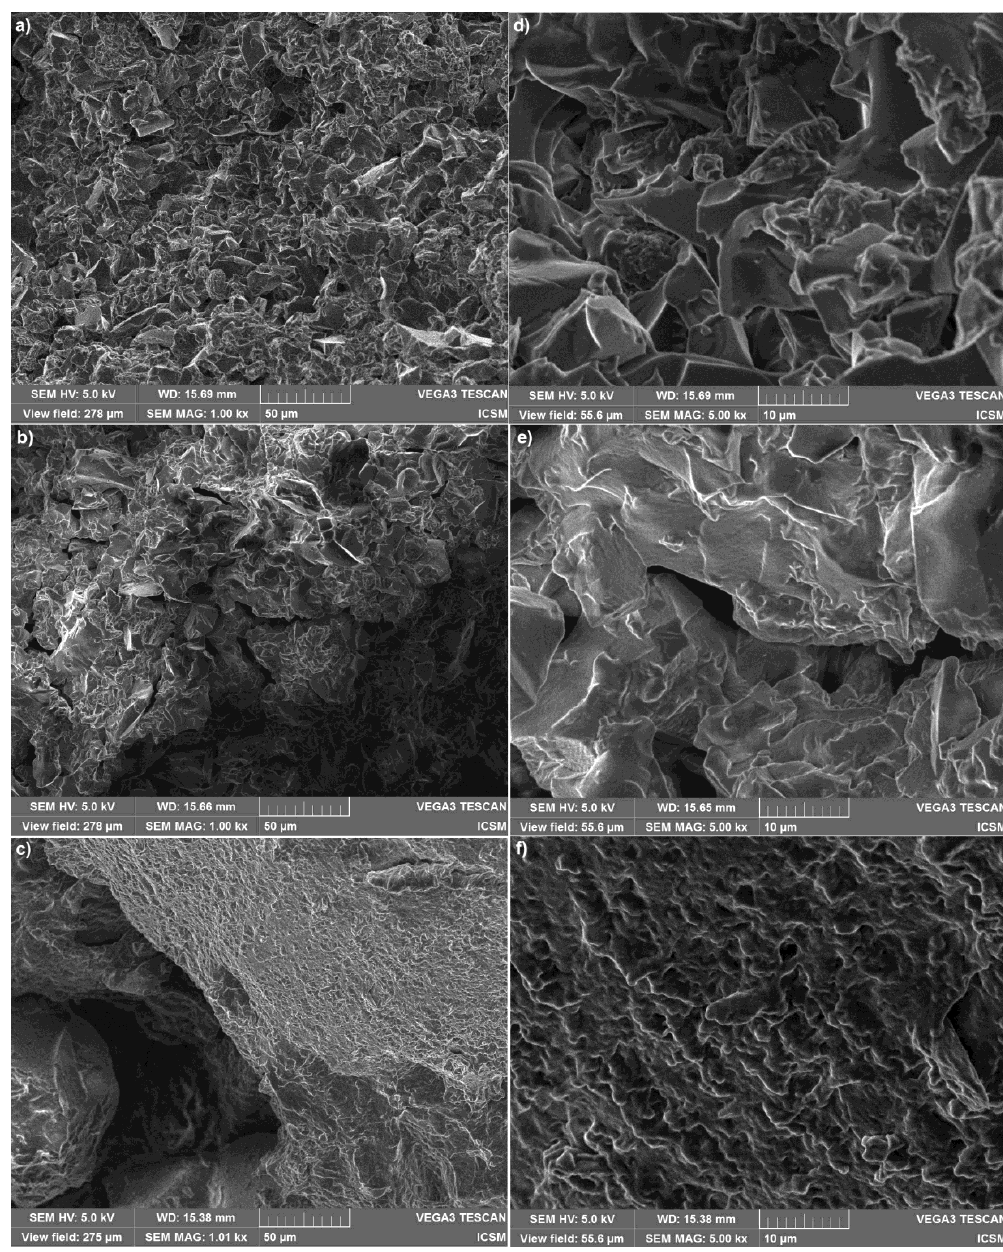
Figure 3. SEM images of different magnifications of 1000X for ( a ) EGCD, ( b ) PEGCD1, ( c ) PEGCD2 and 5000X for ( d ) EGCD, ( e ) PEGCD1 and ( f )